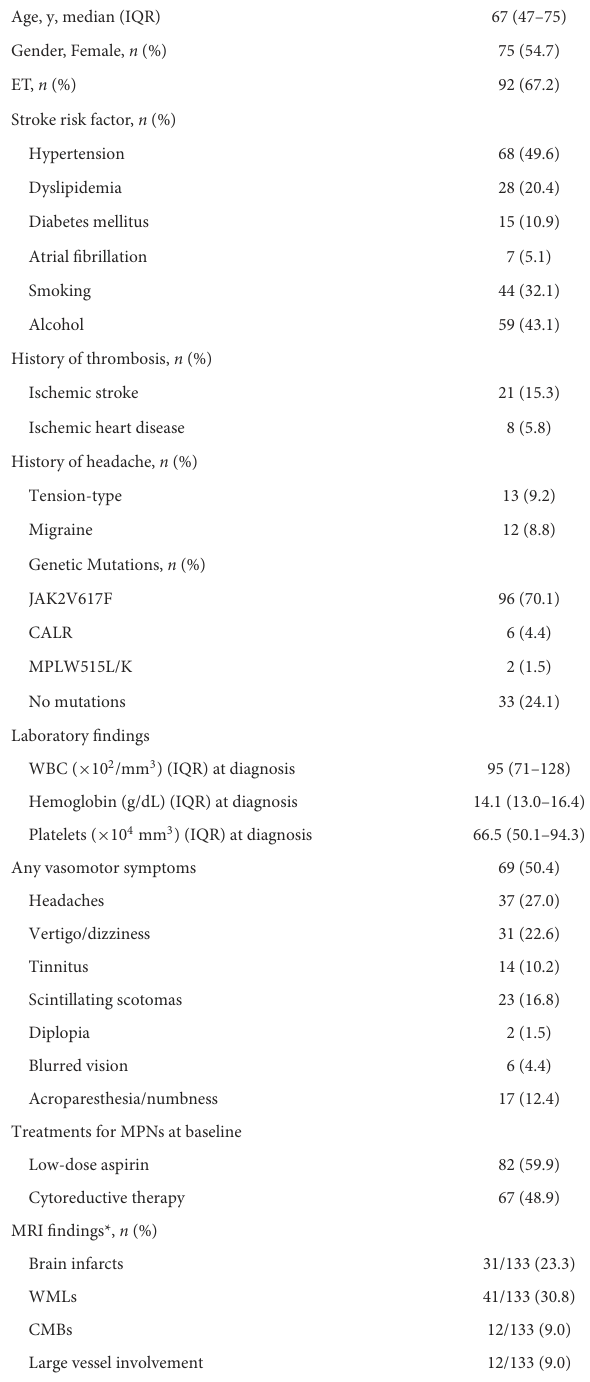
TABLE 1 Baseline demographics in patients with